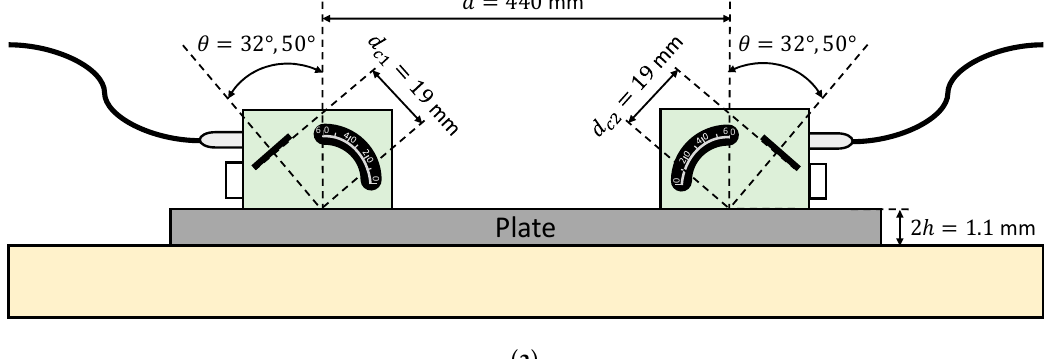
Table 1. Specimen data. Parameters